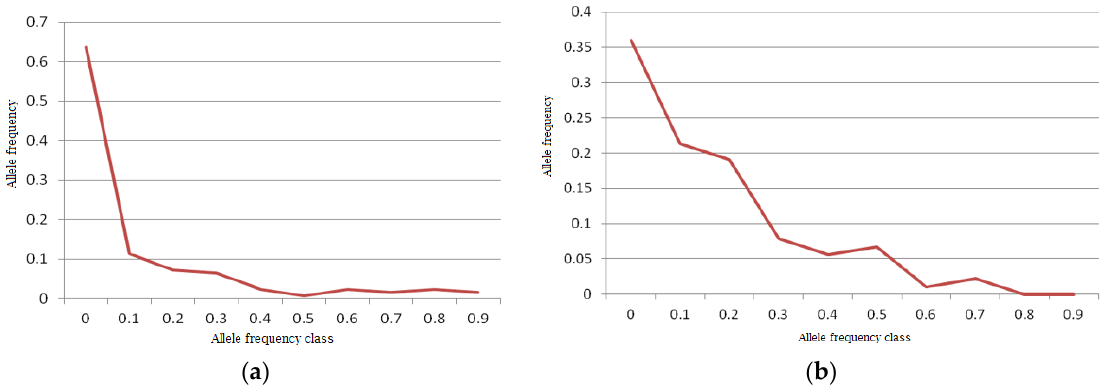
Figure 6. Distribution of allelic in the Indian Mithun population (( a ); typical L shape—no bottleneck) and gaur population (( b ); mode shift observed—bottleneck) by the qualitative graphical test.